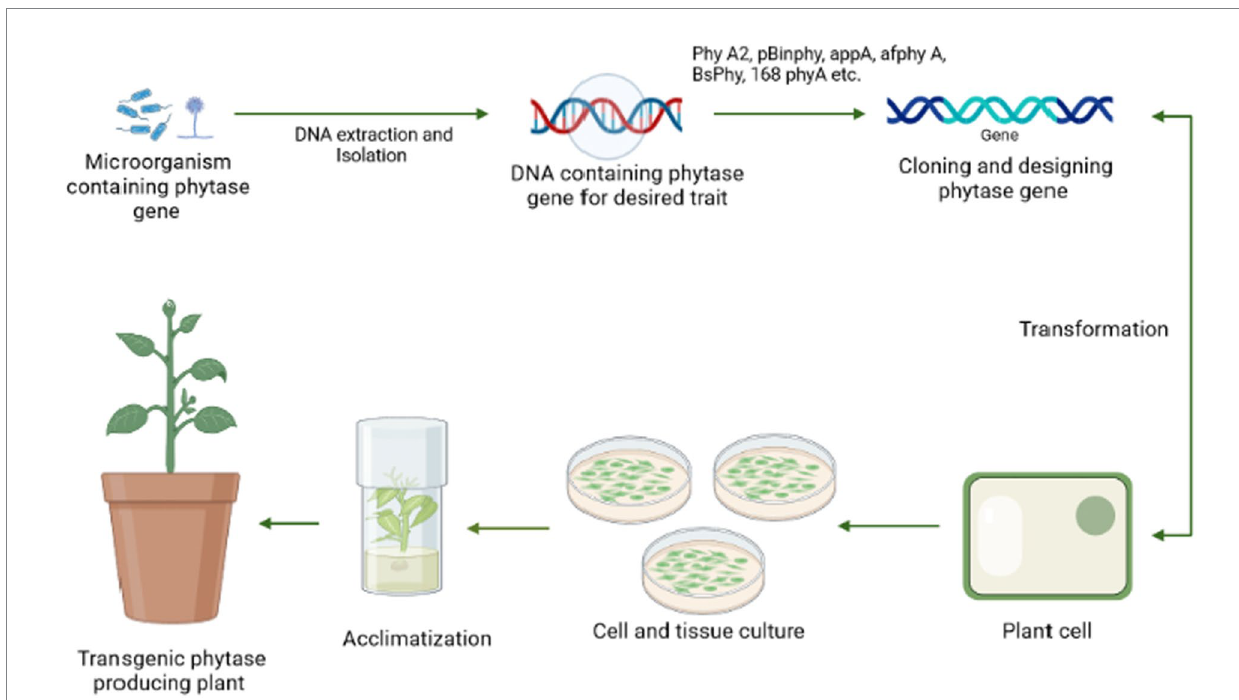
FIGURE 6 A pictorial representation of the steps involved in the generation of a transgenic plant beginning with the screening of an efficient microorganism possessing phytase gene followed by DNA extraction, cloning of phy gene, and transformation to the plant cell, which is further tested in vivo by plant tissue culture and then finally implemented to the